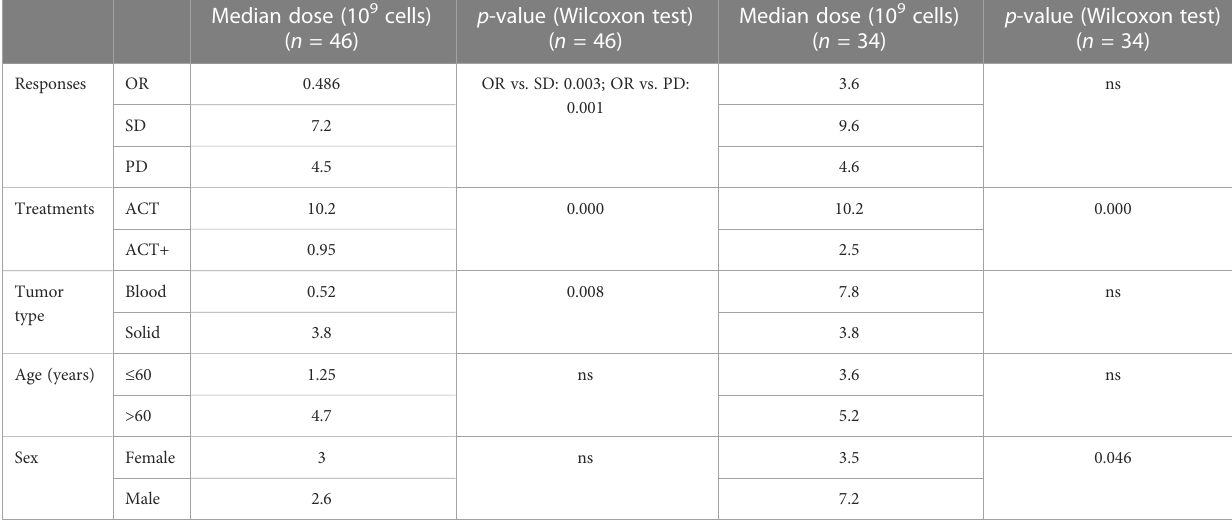
TABLE 5 Cell dosage differences by treatment outcome, strategy, tumor type, age, and sex in gd T cell immunotherapy ( n = 46). p -value (Wilcoxon test) Median dose (10 9 cells) ( n = 46) ( n = 46)